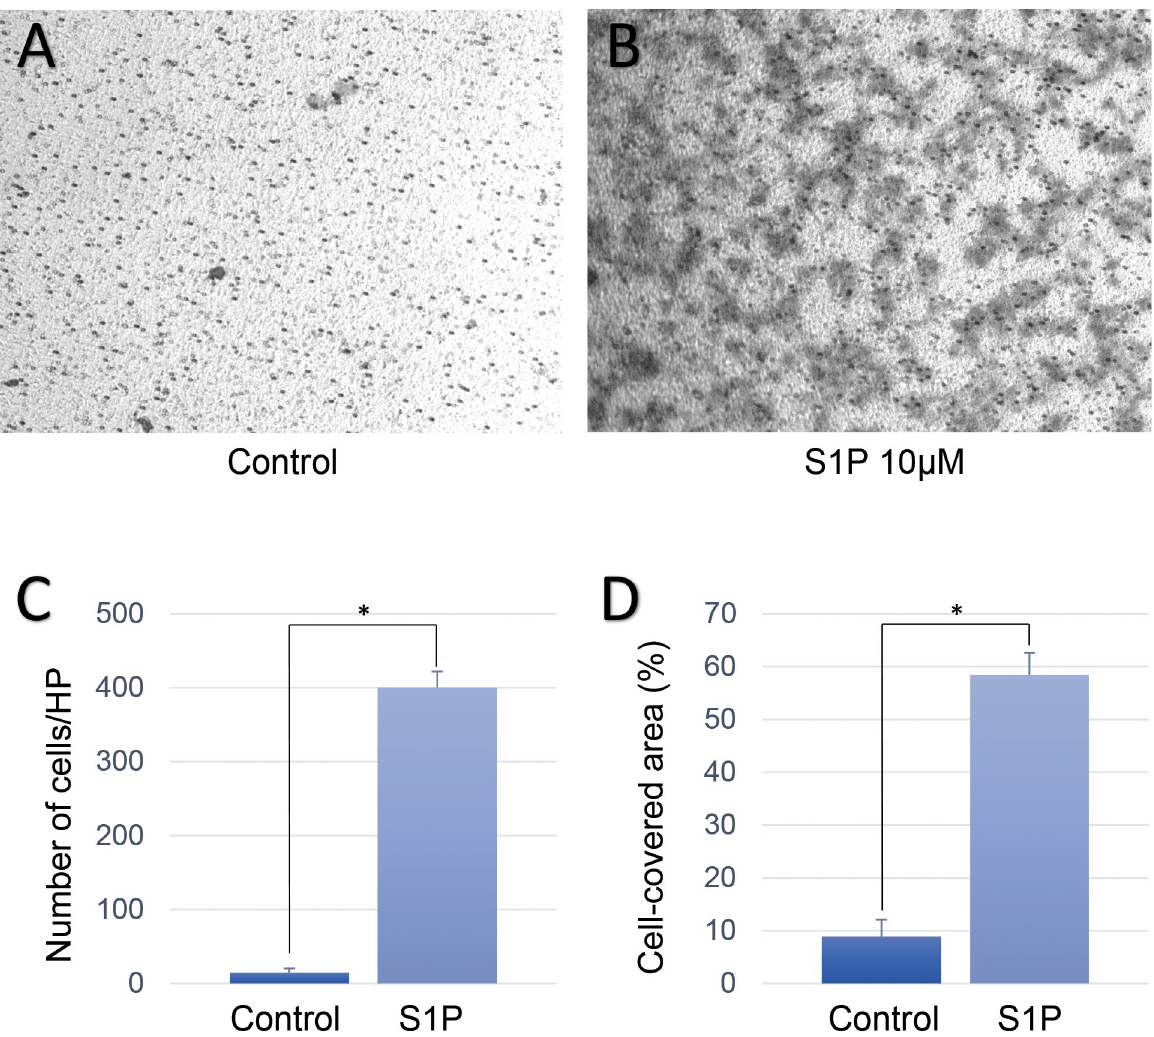
Fig 4. Results of the transwell test in human Muller glial cells. Representative images of the control group (A), and sphingosine-1-phosphate (S1P) group (B). (C) Bar graph that shows the results of the statistical analysis of the number of migrated cells in the different groups (15.00 ± 5.61 cells/HP for control group, 400.60 ± 21.57 cells/HP for S1P group; p < 0.001). (D) Bar graph that shows the results of the statistical analysis of the percentage of the migrated cell-covered area relative to the total area (8.94 ± 3.17 cells/HP for control group, and 58.48 ± 4.14 cells/HP for S1P group; p < 0.001). � p <